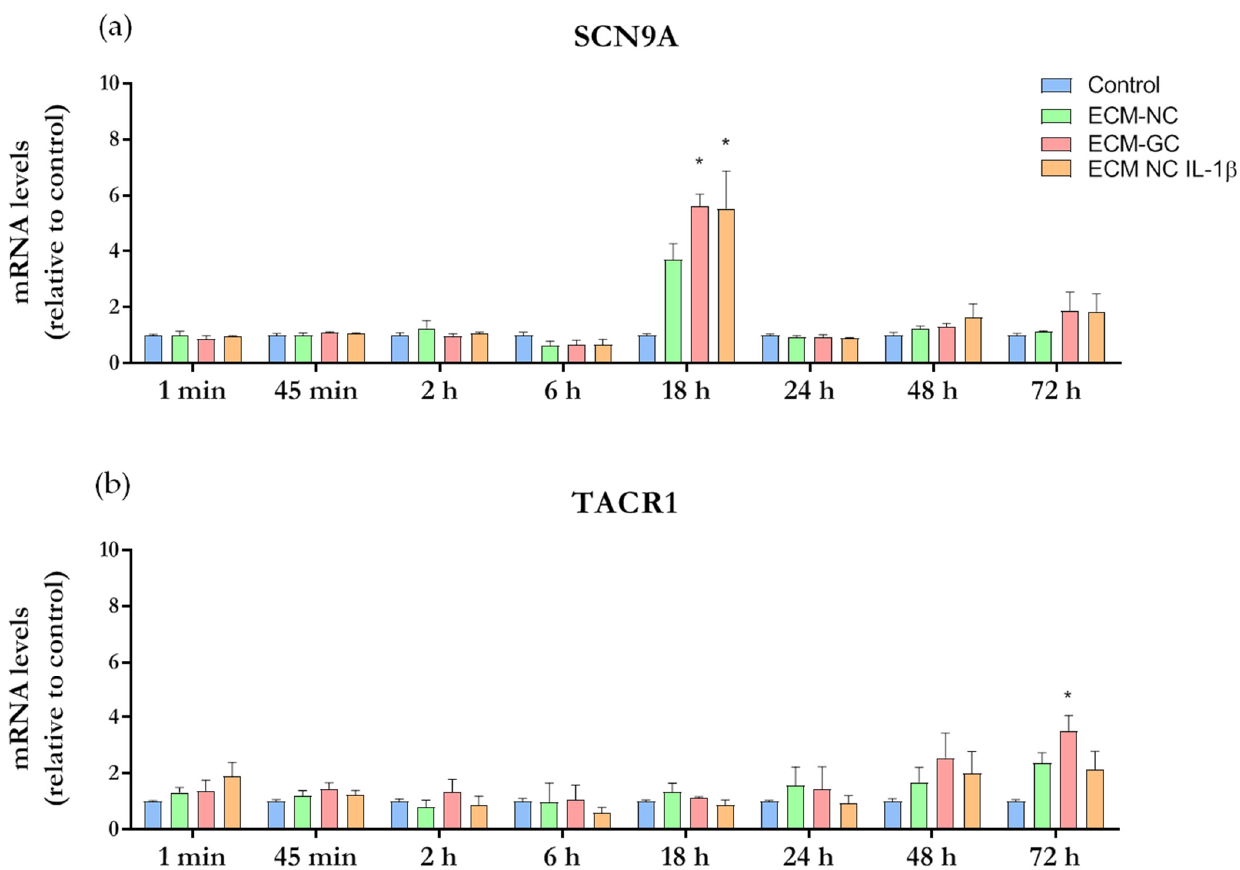
Figure 9. Time course of gene expression analysis. Sensory neuron-like cells were incubated with media culture (control), ECM-NC or ECM-GC or ECM-NC plus IL-1 β for 1 min, 45 min, 2 h, 6 h, 18 h, 24 h, 48 h, and 72 h. Gene expressions were normalized by PPIA and HPRT1 housekeeping genes. Data were analyzed by two-way ANOVA with post hoc testing by Tukey (* p < 0.05 different from control). NC (normal collagen), GC (glycated collagen). Three independent and similar assays were performed in triplicate. ( a ) SCN9A and ( b ) TACR1.